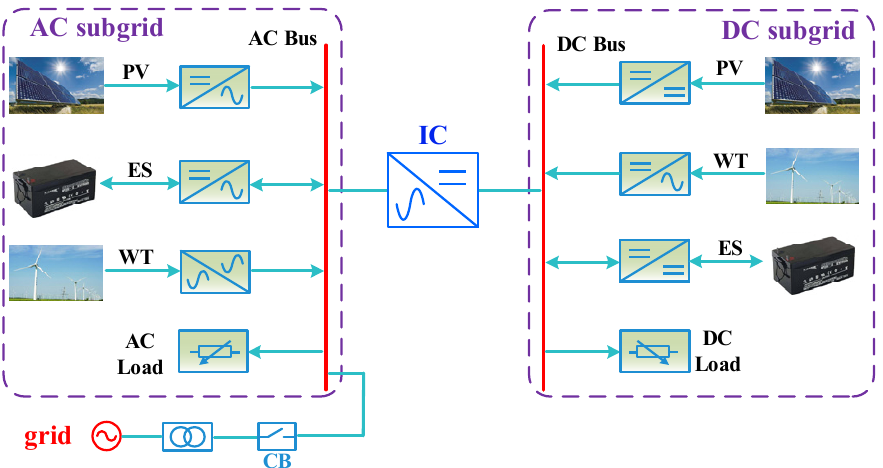
Figure 1. Typical structure of hybrid AC/DC microgrid.